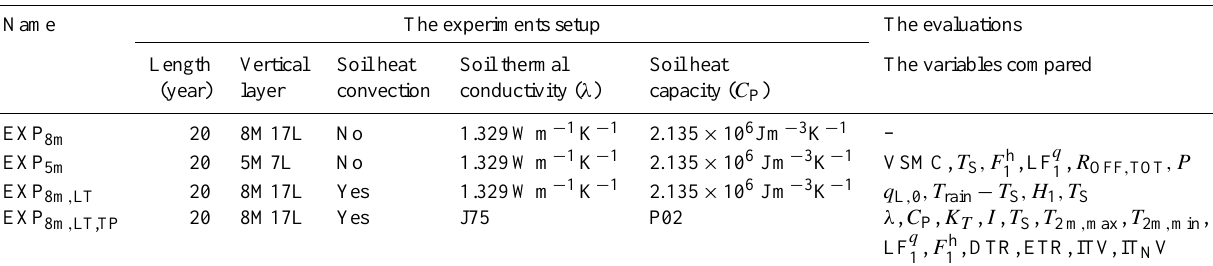
Table 4. The parameterization settings and evaluations for LMDZOR 3-D